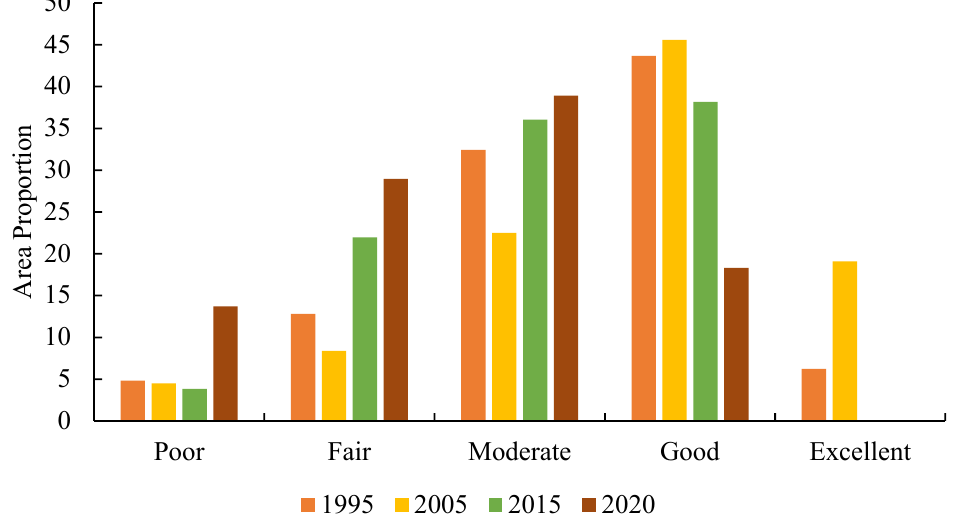
Table 5. Area and proportion of the IRSEI over 1995 to 2020 in Wuhan city (unit: km 2 , %).